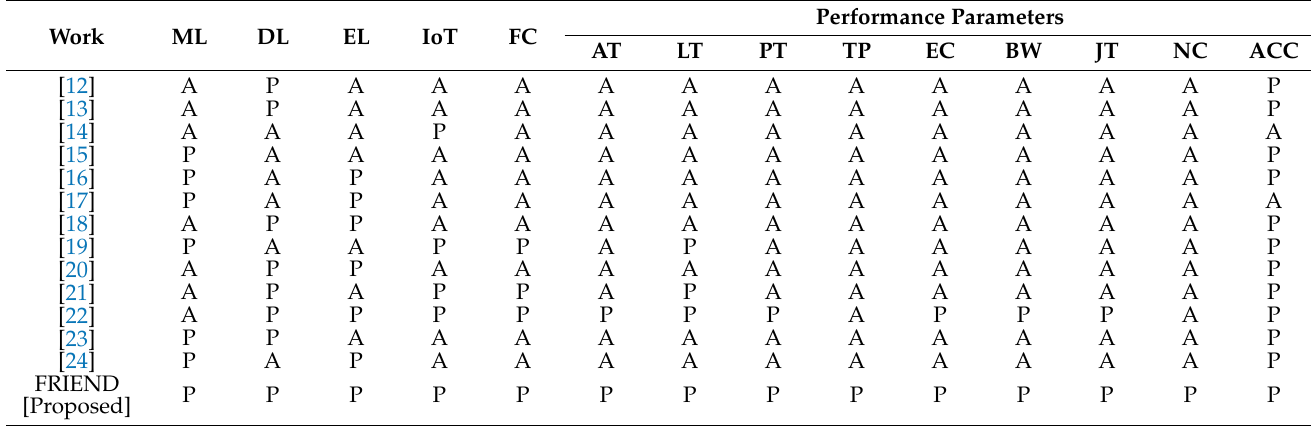
Table 10. Comparison of FRIEND with some considered state-of-the-art works based on the consid- ered approaches and network